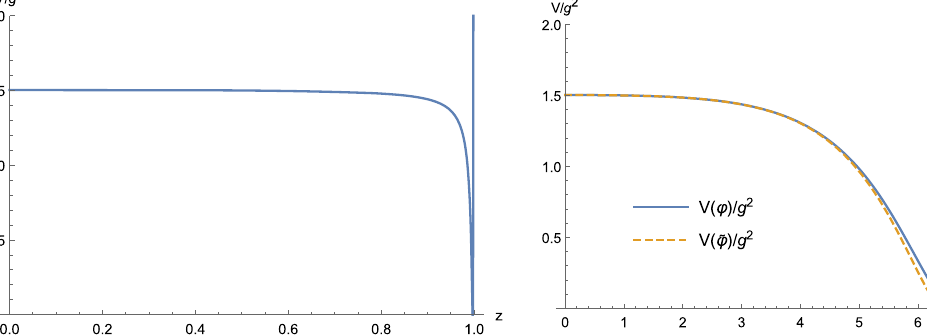
(cid:12) (cid:13) √ ˜ ϕ/ 2 α (canonical in β = 0